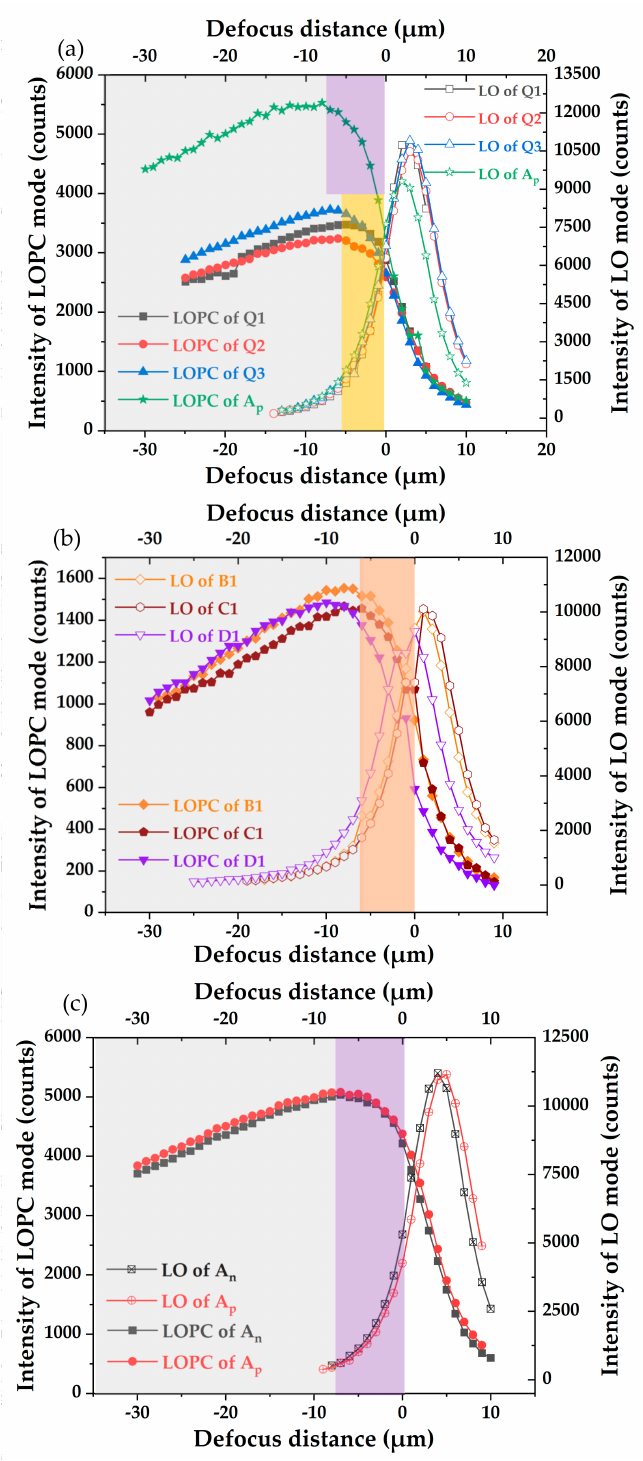
Figure 7. The variation of the LO and LOPC mode peak intensities with the defocus distance using the 50L × lens, in which the gray blocks represent the substrates and the di ff erent colored blocks represent the epitaxial layers of di ff erent samples according to Table 1: ( a ) LO and LOPC mode intensity distribution in the depth direction of A p and Q; ( b ) LO and LOPC mode intensity distribution in the depth direction of B1, C1, and D1; ( c ) LO and LOPC mode intensity distribution in the depth direction of A n and A p . The step of depth profiling is 1 µ